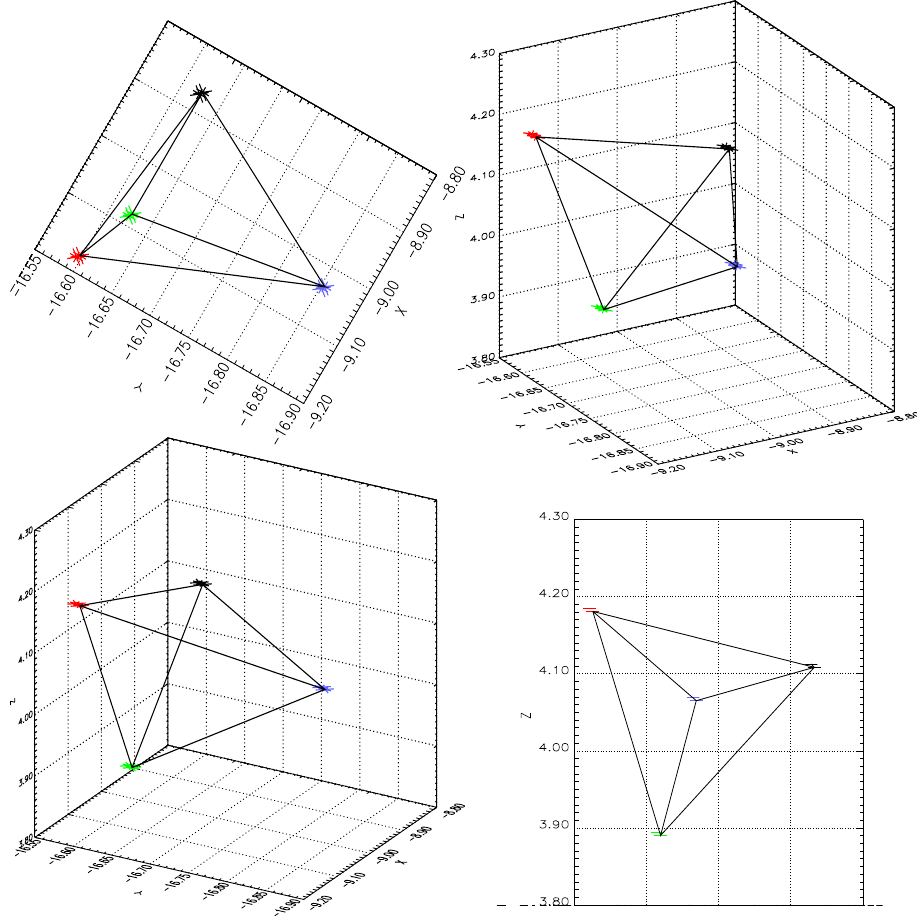
Fig. 3. Cluster constellation at 05:00 UT on 3 July 2001 from 4 different views in GSM coordinates: x,y -plane (top left), 30 degree rotation about z - and x -axis (top right), 60 degree ration about z-axis and 30 degree rotation about x -axis from (bottom left), view from − y -axis (bottom right). Black, red, green and blue colors represent sc1, sc2, sc3 and sc4, respectively.